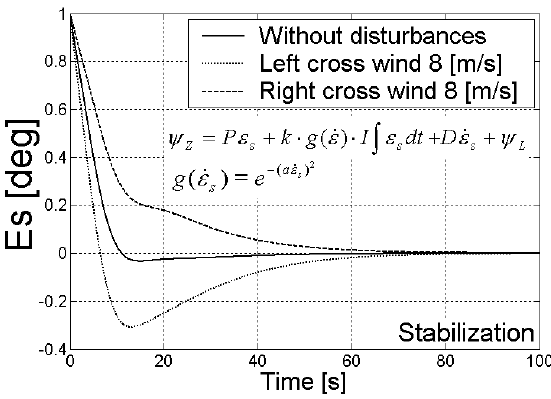
Fig 4a. Simulation results for whole approach with the use of control laws 13 and 14